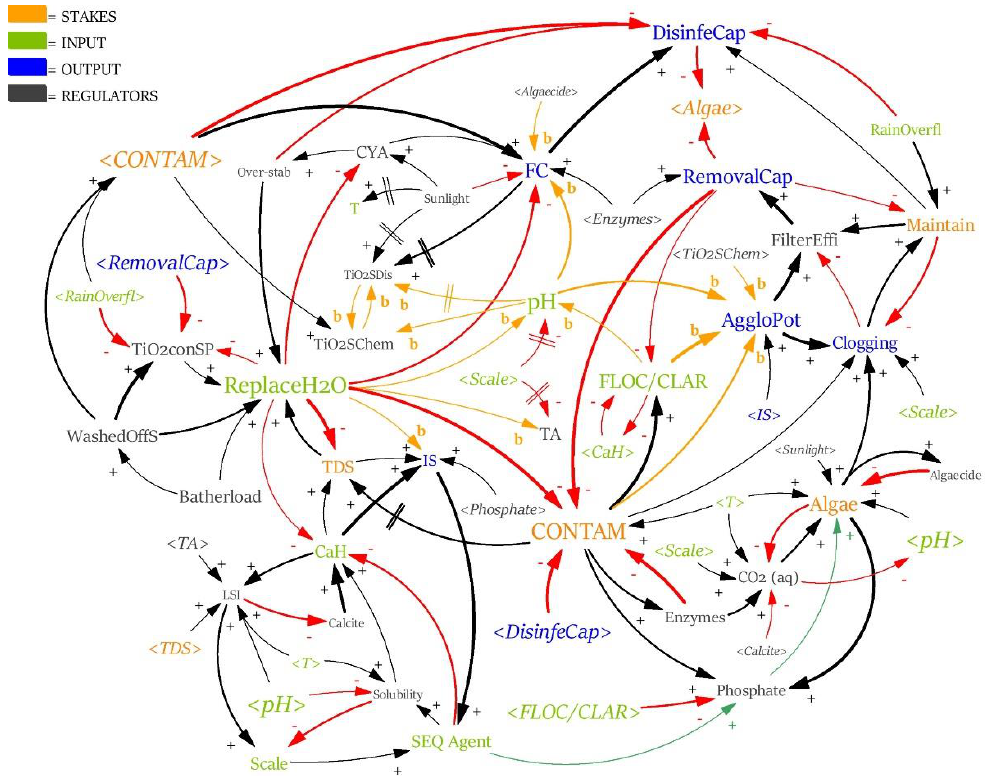
Figure 8. Final CLD: TiO 2 concentration in SPW. Variable colour code is based on the variable place- ment in the direct impact map (see Figure 7); arrow colour code is the same as in the previous CLDs.